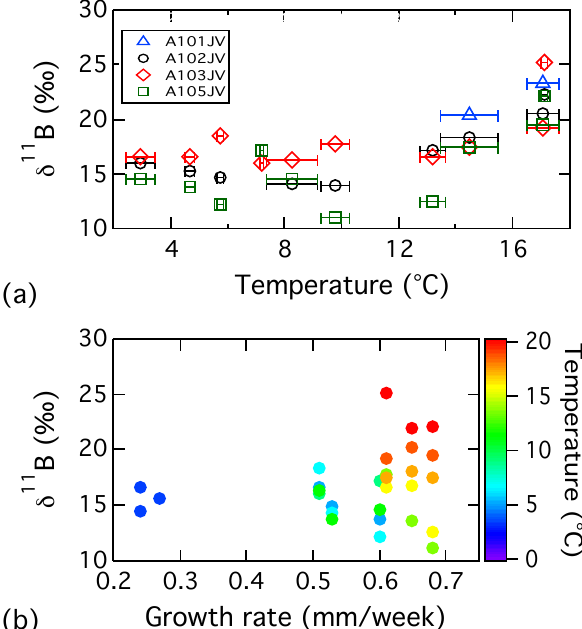
Figure 8. The comparisons between the shell δ 11 B and (a) the cor- responding culture water temperature and (b) the growth rates for individual shells. Colors shown in (b) represent the temperature cor- responding to each data point, with low temperatures in blue to high temperatures in